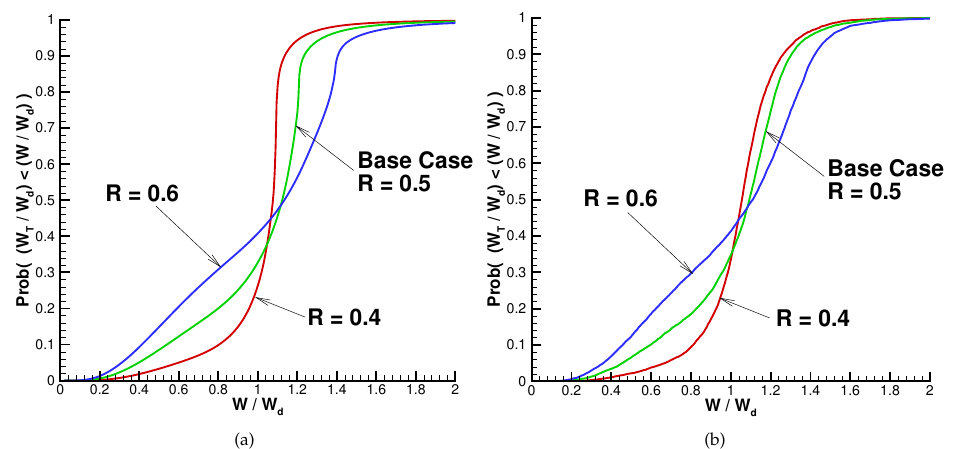
Figure 9. Cumulative distributions of real terminal wealth with different salary replacement ratios R for the QS optimal strategy. Input data provided in Tables 1 and 2, except as noted. Synthetic market results computed using Monte Carlo simulations with 160,000 sample paths. Historical market results based on 10,000 bootstrap resampled paths using historical data from 1926:1 to 2015:12 with expected blocksize ˆ b = 2 years; surplus cash included. ( a ) synthetic market; b ) historical